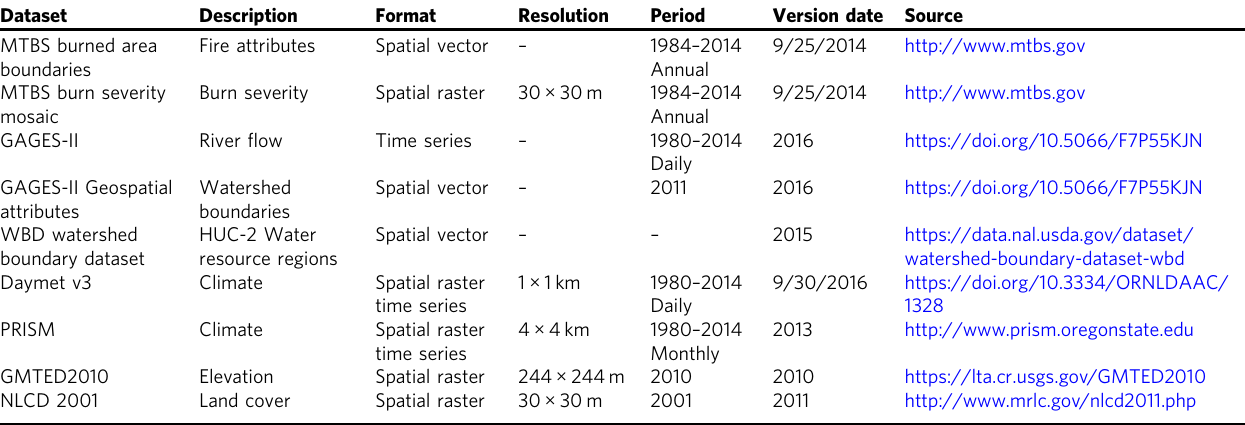
Table 1 Characteristics of high-resolution spatial datasets and time series used to determine wildland fi re impacts on river fl ow